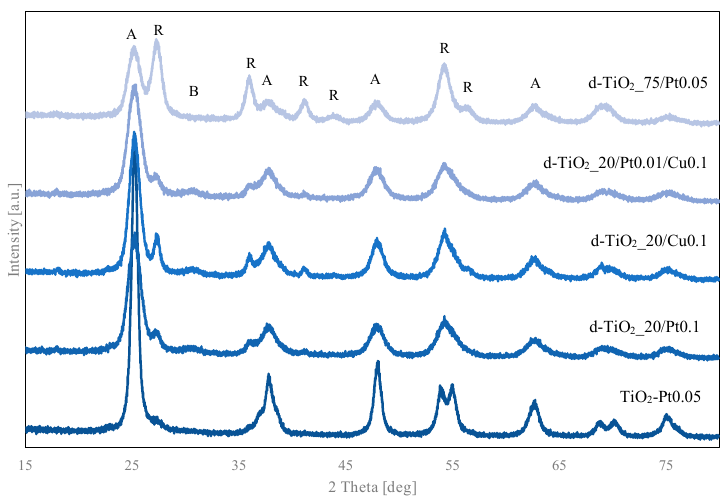
Figure 2. X-ray di ff ractometry (XRD) patterns for selected defective d-TiO 2 -Pt / Cu photocatalysts Figure 2. X-ray diffractometry (XRD) patterns for selected defective d-TiO 2 -Pt/Cu photocatalysts (A— (A—anatase, B—brookite, and anatase, B—brookite, and R—rutile). Table 3. Crystalline phases characteristic for obtained defective d-TiO 2 -Pt/Cu samples.